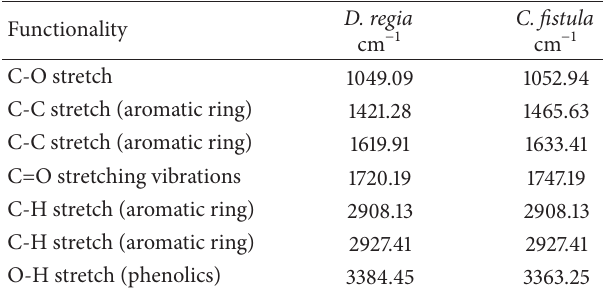
Table 7: FTIR spectroscopic data of methanolic extracts of seed samples of D. regia and C. fistula .